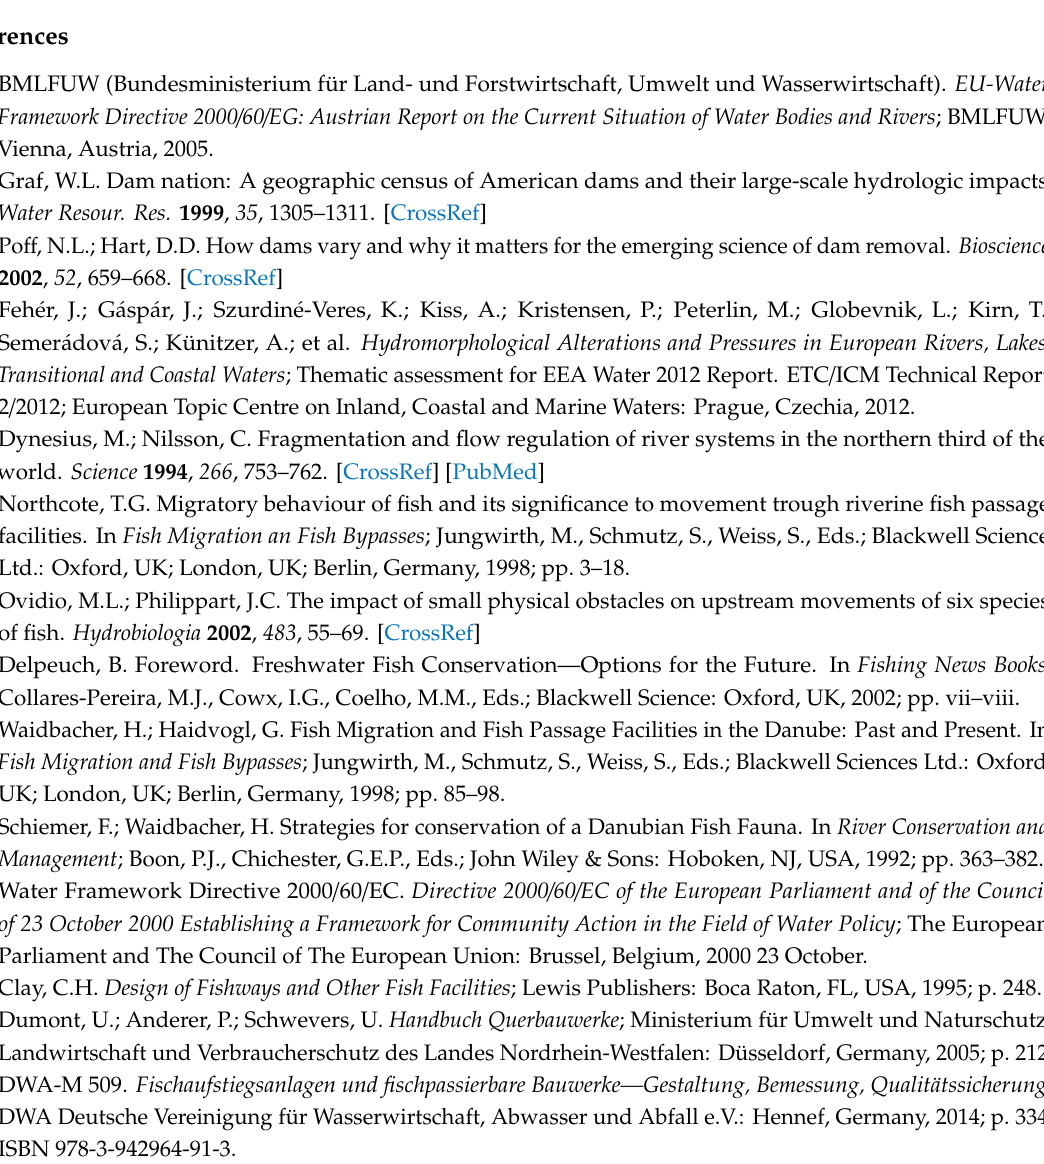
Figure S1: Length frequency distributions of detected fish species, selected examples: (a) bream, (b) roach, (c) rainbow trout, (d) burbot, (e) sneep, (f) brown trout, (g) chub, (h) perch. Video S1: School of sneep in FishCam. Video S2: school of bleak in